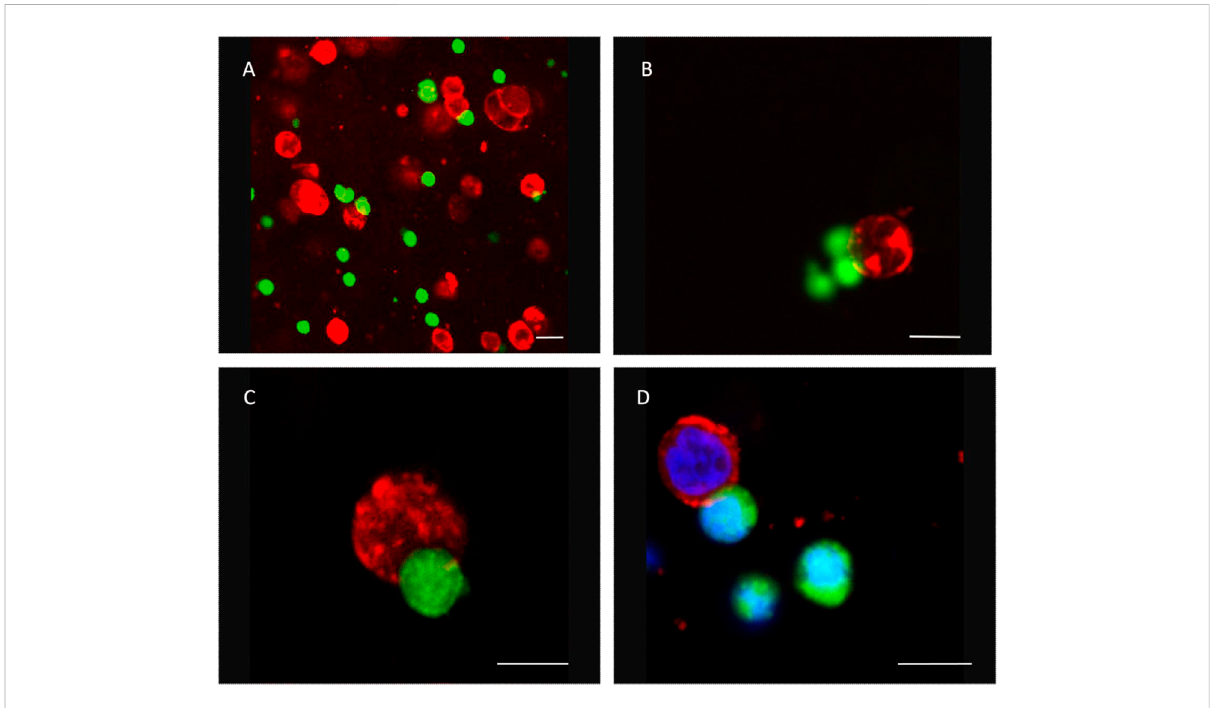
FIGURE 3 NKcellsandNBcellscoembeddedina3Dalginatescaffold.ConfocalMicroscopyAcquisitionandAnalysisofCFSE-labeledNKcells(green)and GD2-positive NB cells (red) co-embedded in 3D alginate scaffold and cultured for 24 h. In panel D, nuclei have been stained with DAPI. (A) ×20 magni fi cation (representative square fi eld of ×173173 micron); (B – D) ×40 magni fi cation. Scale bar: 10